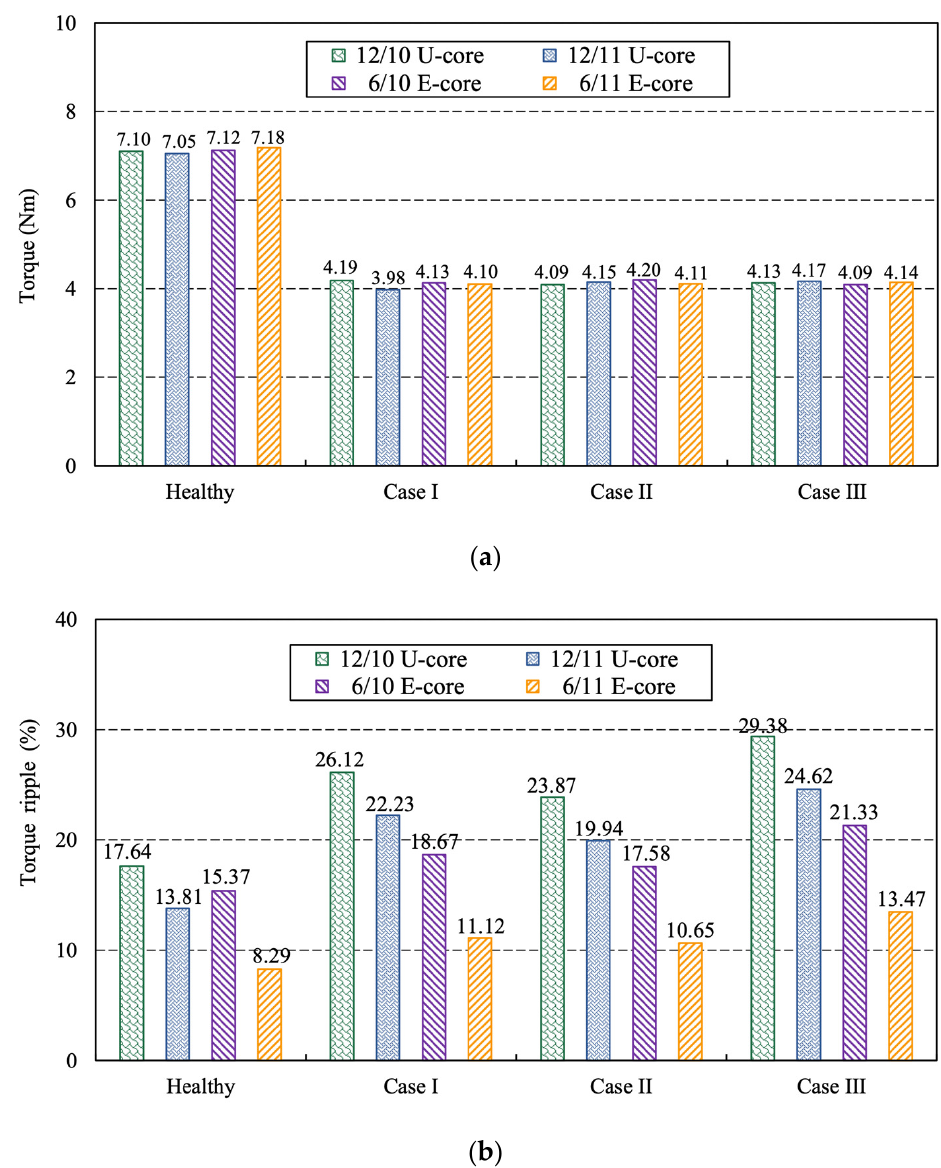
Figure 20. Comparison of electromagnetic torque and torque ripple of four candidates between healthy and two-phase open-circuited fault-tolerant control operation. ( a ) Average electromagnetic torque; ( b ) torque ripple.